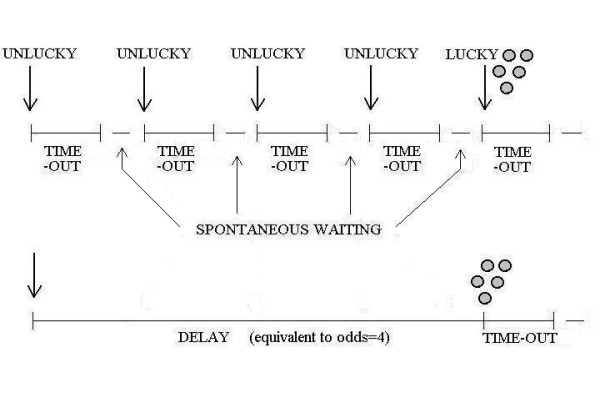
Schematic diagram showing equivalence between ID and PD protocols at the mathematical indifference point (odds against reinforcing = 4). Arrows represent nose-poking for large reward by rats. In the PD protocol, there are an average of four "unlucky" events (omissions) before a "lucky" event (5-pellet food delivery). In the ID protocol, the delay interval should be at least four times the time-out (delay = 15 × 4 = 60 seconds) to reproduce a 5-pellet delivery with approximately the same temporal characteristics as in the PD protocol. To turn this ideal situation into a more realistic account, four times the spontaneous waiting observed between two consecutive trials (further 10 × 4 = 40 seconds) shall be added to delay duration (see Table 1). To optimize performance for long-term benefit, choice should be LL/L before the mathematical indifference point, and SS beyond it.